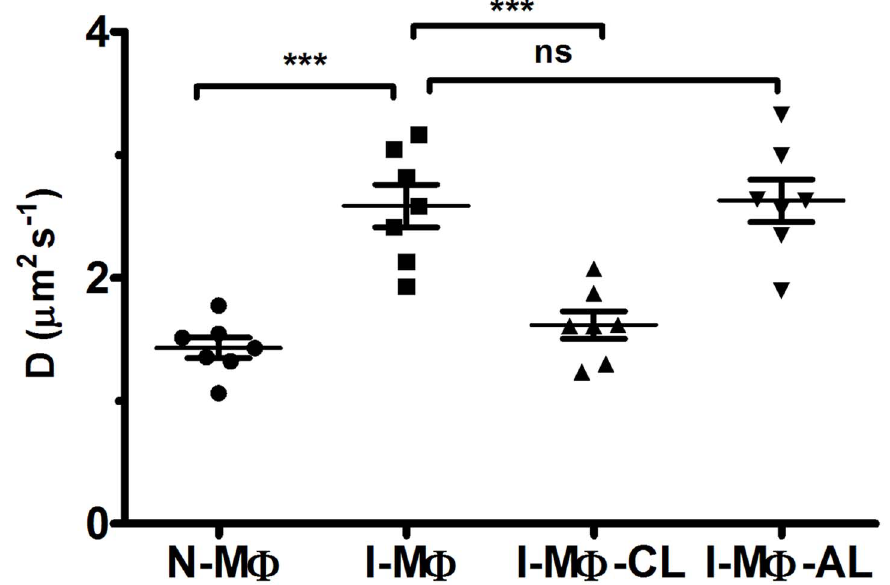
Figure 5. Lateral mobility of PLC d 1. Fluorescence recovery after photo bleaching was measured in plc d 1-gfp transfected RAW 264.7 cells. The diffusion Coefficient (D) of PLC d 1-GFP for N-M W , I-M W , I-M W -CL and I-M W -AL was measured using equation (1.3). The data represents average of 7 cells with 6 SD. *** represents p , 0.0005 and ‘ns’ means not significant. doi:10.1371/journal.pntd.0003367.g005 PLOS Neglected Tropical Diseases |